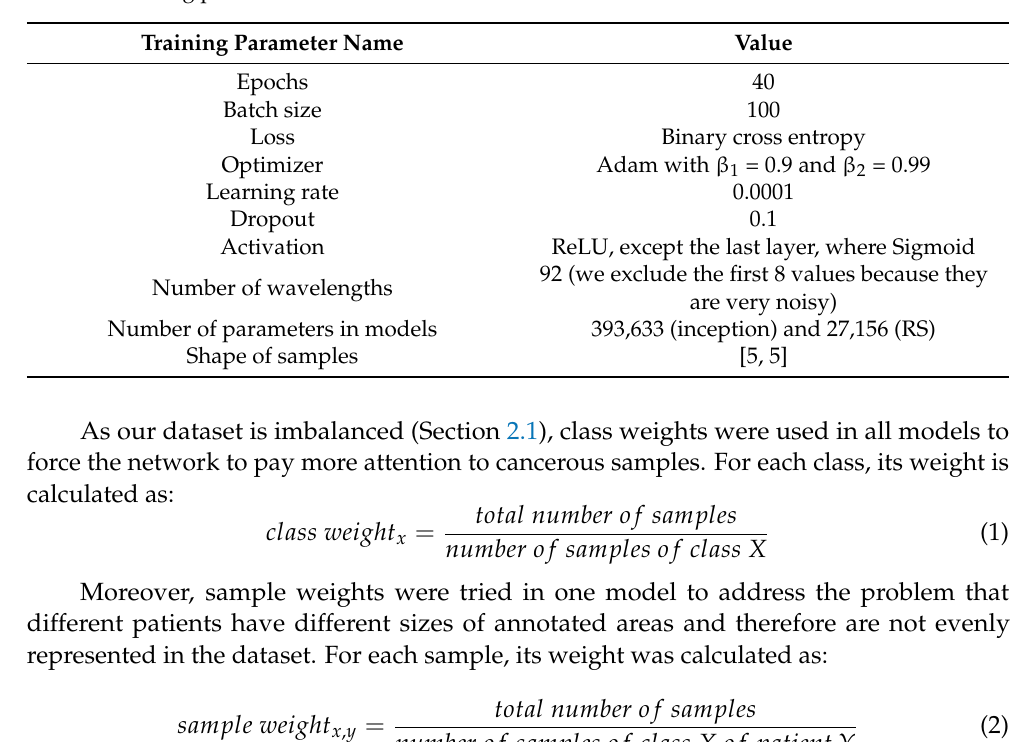
Table 2. Training